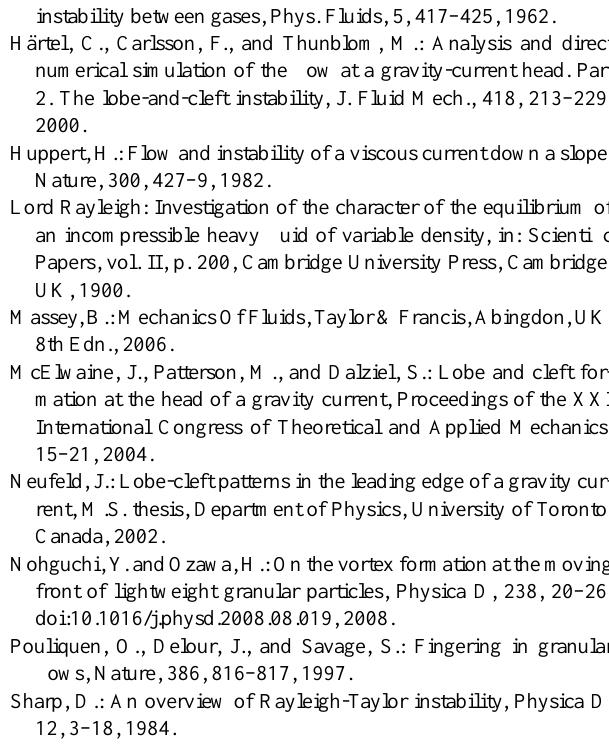
Fig. 12. Non-dimensional wavelength ( ˜ λ d ) versus the Froude number ( Fr d ). Particle sizes: 1.3mm ( 4 ), 1.5mm ( (cid:3) ), 1.8mm ( ♦ ), 2.1mm ( ∇ ), 2.5mm ( ◦ ), 2.7mm ( B ), 5.0mm ( ? ) and 6.8mm ( C ). Marker shades correspond to slope angle: 65 ◦ – clear, through to 85 ◦ – black. Marker size corresponds to the size of the release volume. Dashed line shows linear fit, ˜ λ d = 2 . 3 F r d + 1 (Eq. 8).